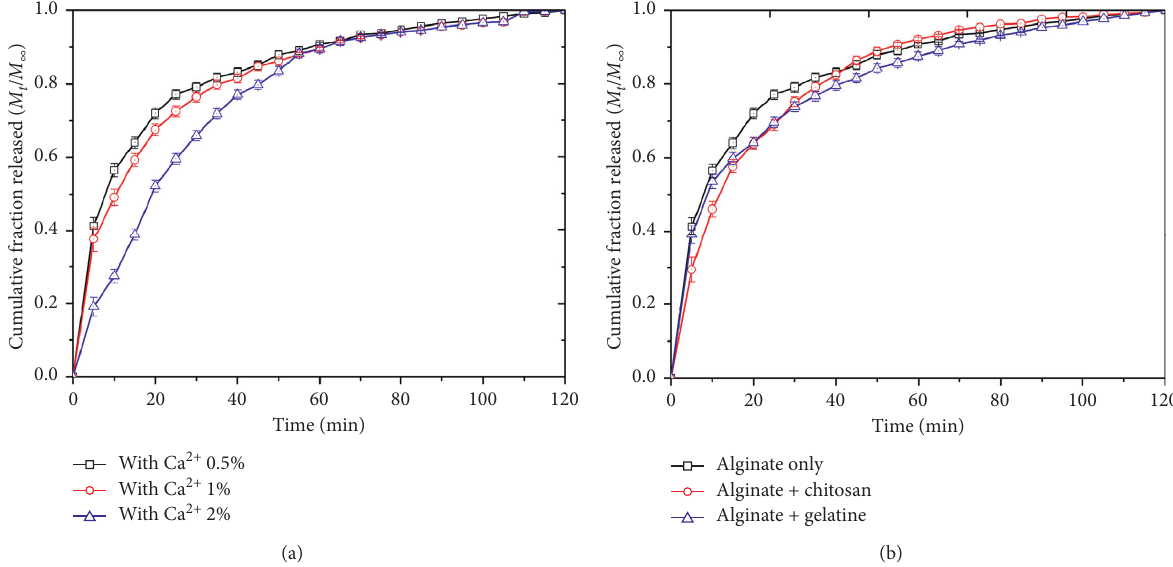
Figure 4: Cumulative fraction released profiles of drug molecules in the acetate buffer solution (pH � 4) from the beads prepared (a) in different Ca 2+ concentration solutions and (b) with surface modification with chitosan and